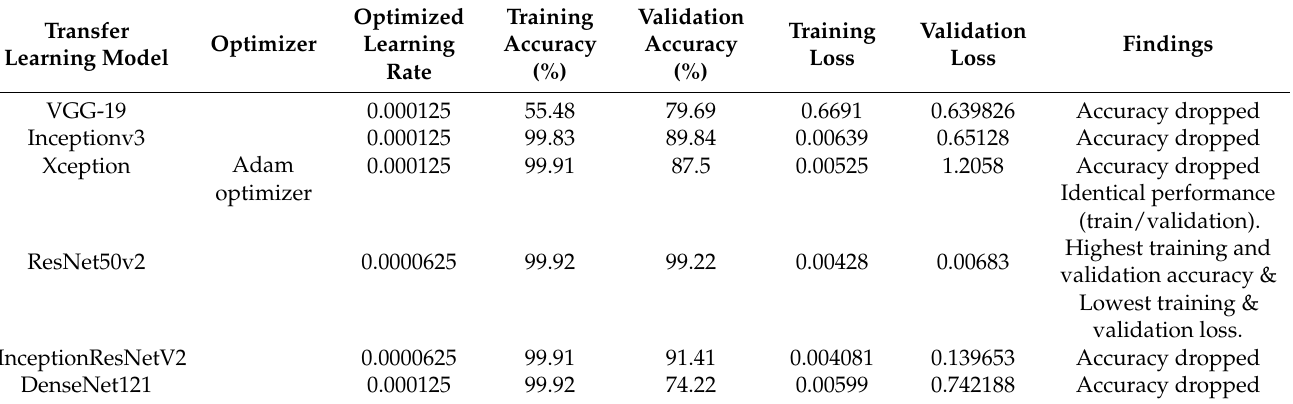
Table 4. Comparative performance examination of the six-transfer learning model at their corre- sponding optimized learning